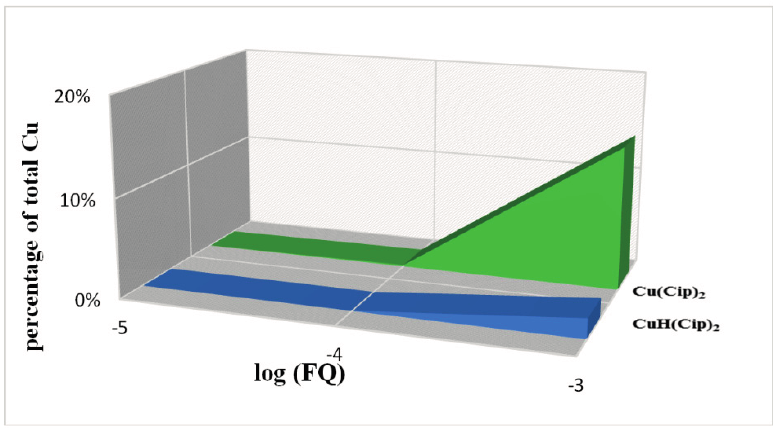
Figure 12. Dominant Cu-Cipro species in blood plasma in the presence of ciprofloxacin (Cip).